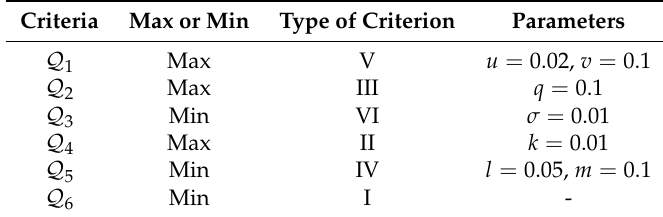
Table 4. Types of criteria and corresponding